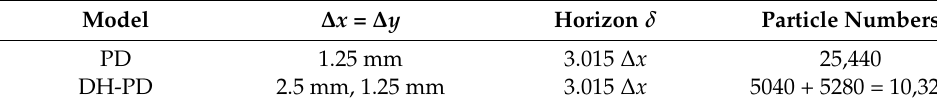
Table 2. Values of peridynamics parameters for the PD and DH-PD models.